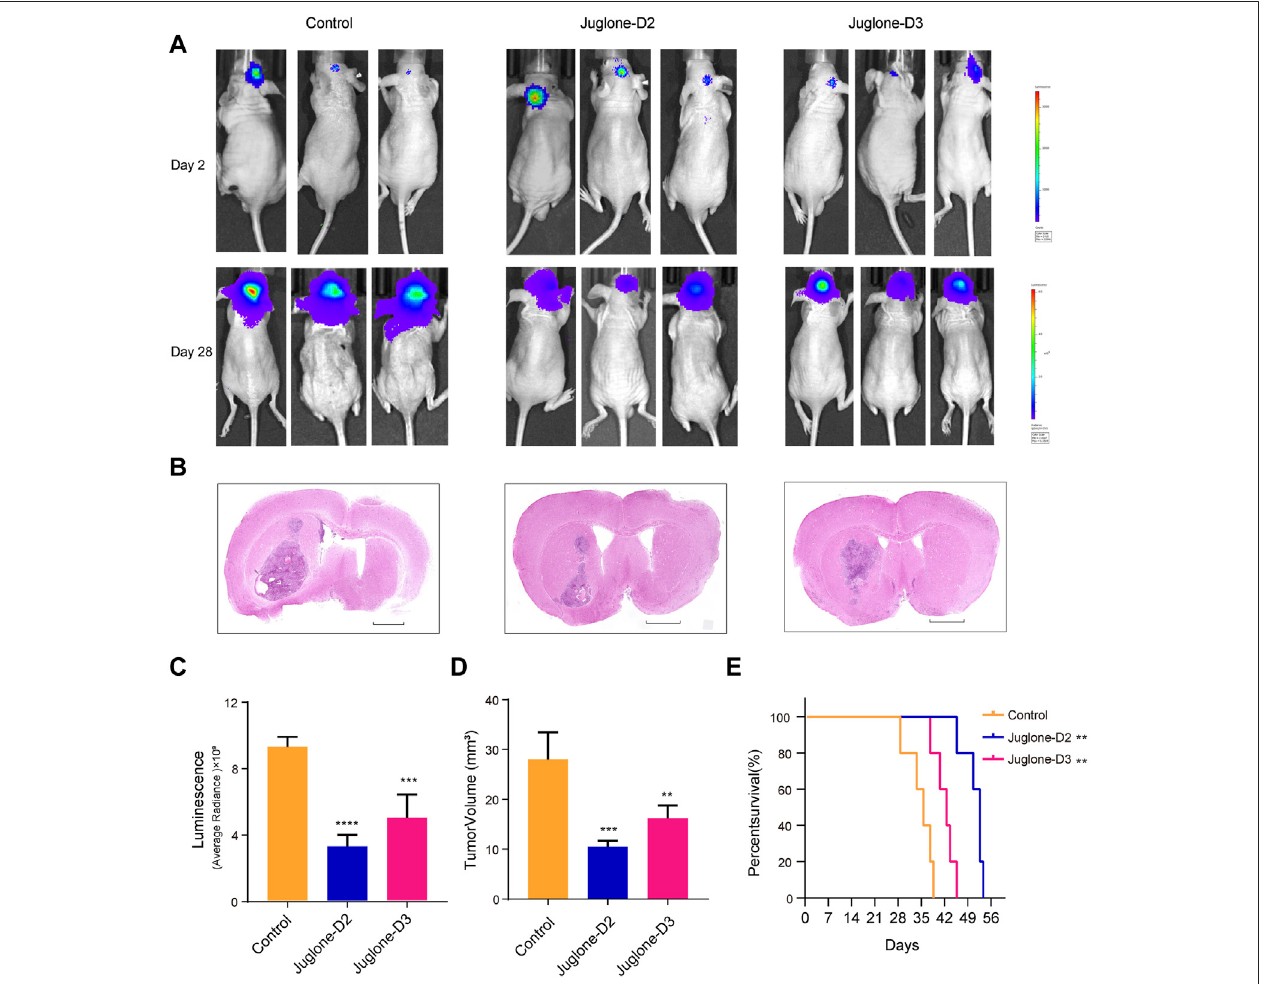
FIGURE 7 | Juglone derivatives could inhibit glioma growth in vivo . (A) Tumor growth was evaluated by detection of bioluminescence, and revealed D2 and D3 inhibit glioma growth in orthotopic glioblastoma mouse model. (B) H and E staining of brain sections con fi rmed the glioma inhibition effect of D2 and D3. Scale bar = 2 mm. (C-D) Luminescence values and tumor volume were measured. (E) Kaplan-Meier analysis revealed increased survival of D2 and D3 group relative to controls. ** p < 0.01, *** p < 0.001, **** p < 0.0001.